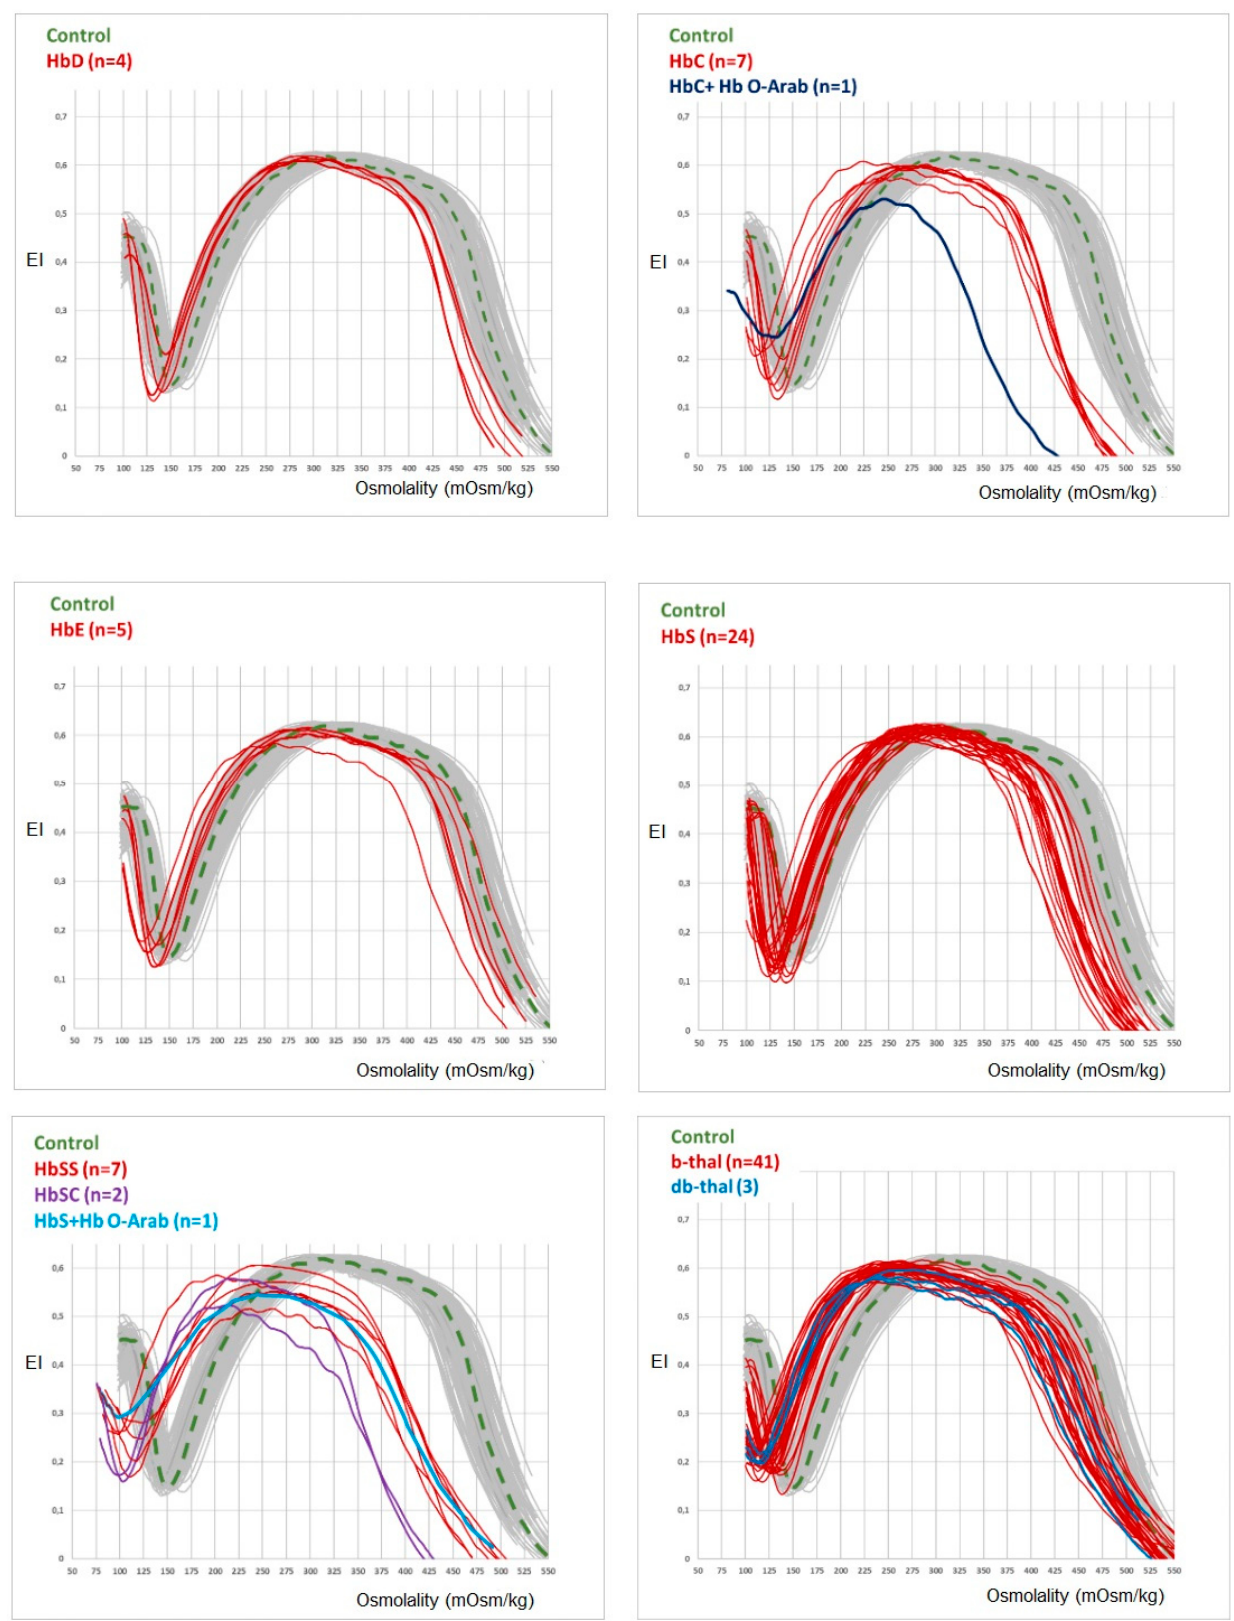
Figure 2. OGE curve profile of the different hemoglobinopathies studied